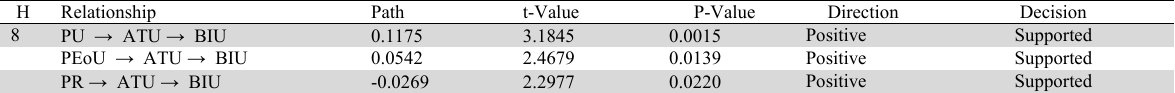
Path Analysis Results, Indirect